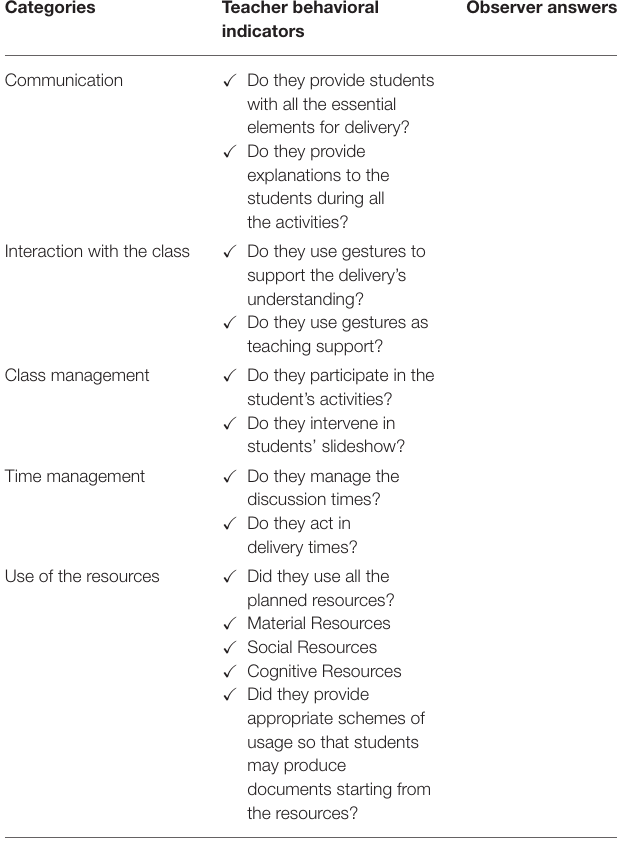
TABLE 3 | Observational